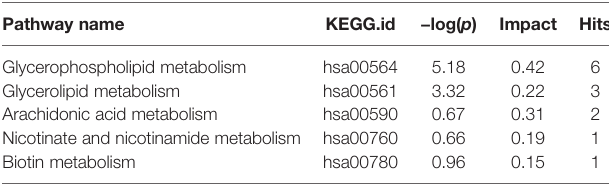
TABLE 2 | Signi fi cantly altered metabolic pathways between PCa and BPH groups with PSA levels at gray zone of 4 – 10 ng/ml. Pathway